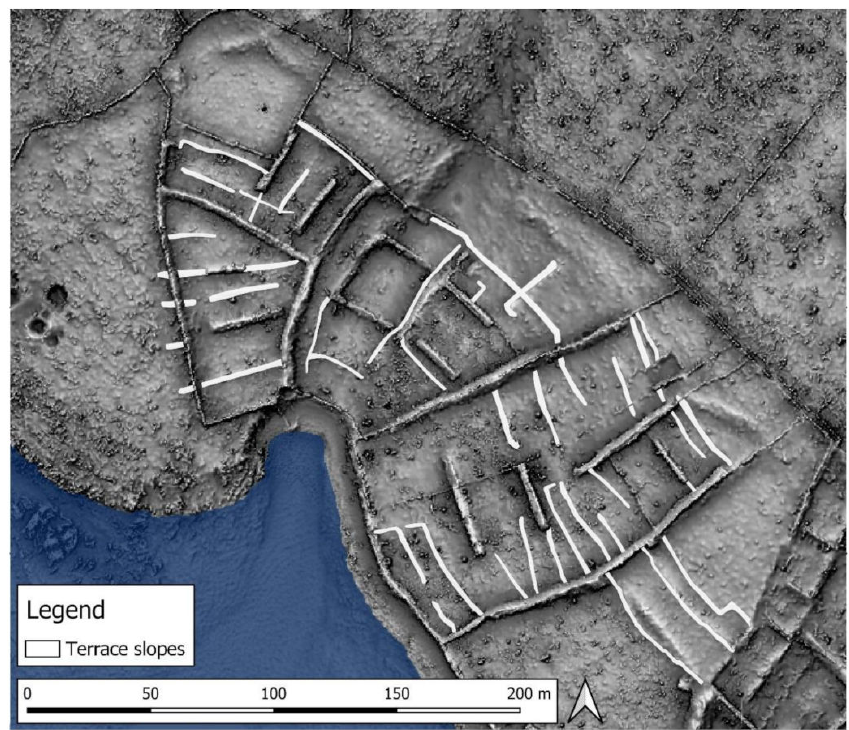
Figure 25. Interpretative mapping of terrace slopes (visualization: combination of slope, hillshade, and Negative Openness (r = 10)).